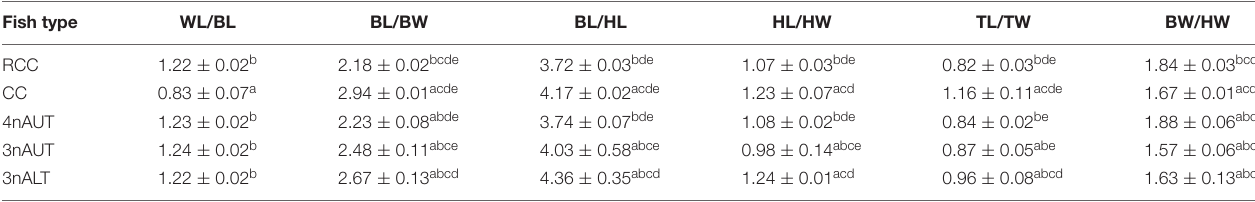
TABLE 3 | Comparison of the measurable traits between the hybrid offspring and their parents. Fish type